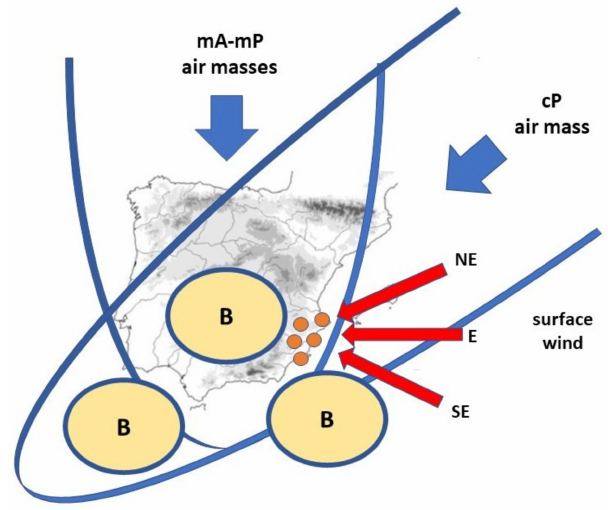
Figure 2. Diagram of the unstable atmospheric situations most favourable for the development of intense rainfall in the study area. Source: Olcina Cantos [14].